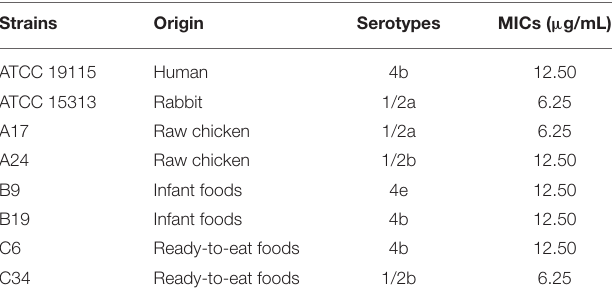
TABLE 1 | Minimum inhibitory concentrations (MICs) of TQ against several Listeria monocytogenes strains.